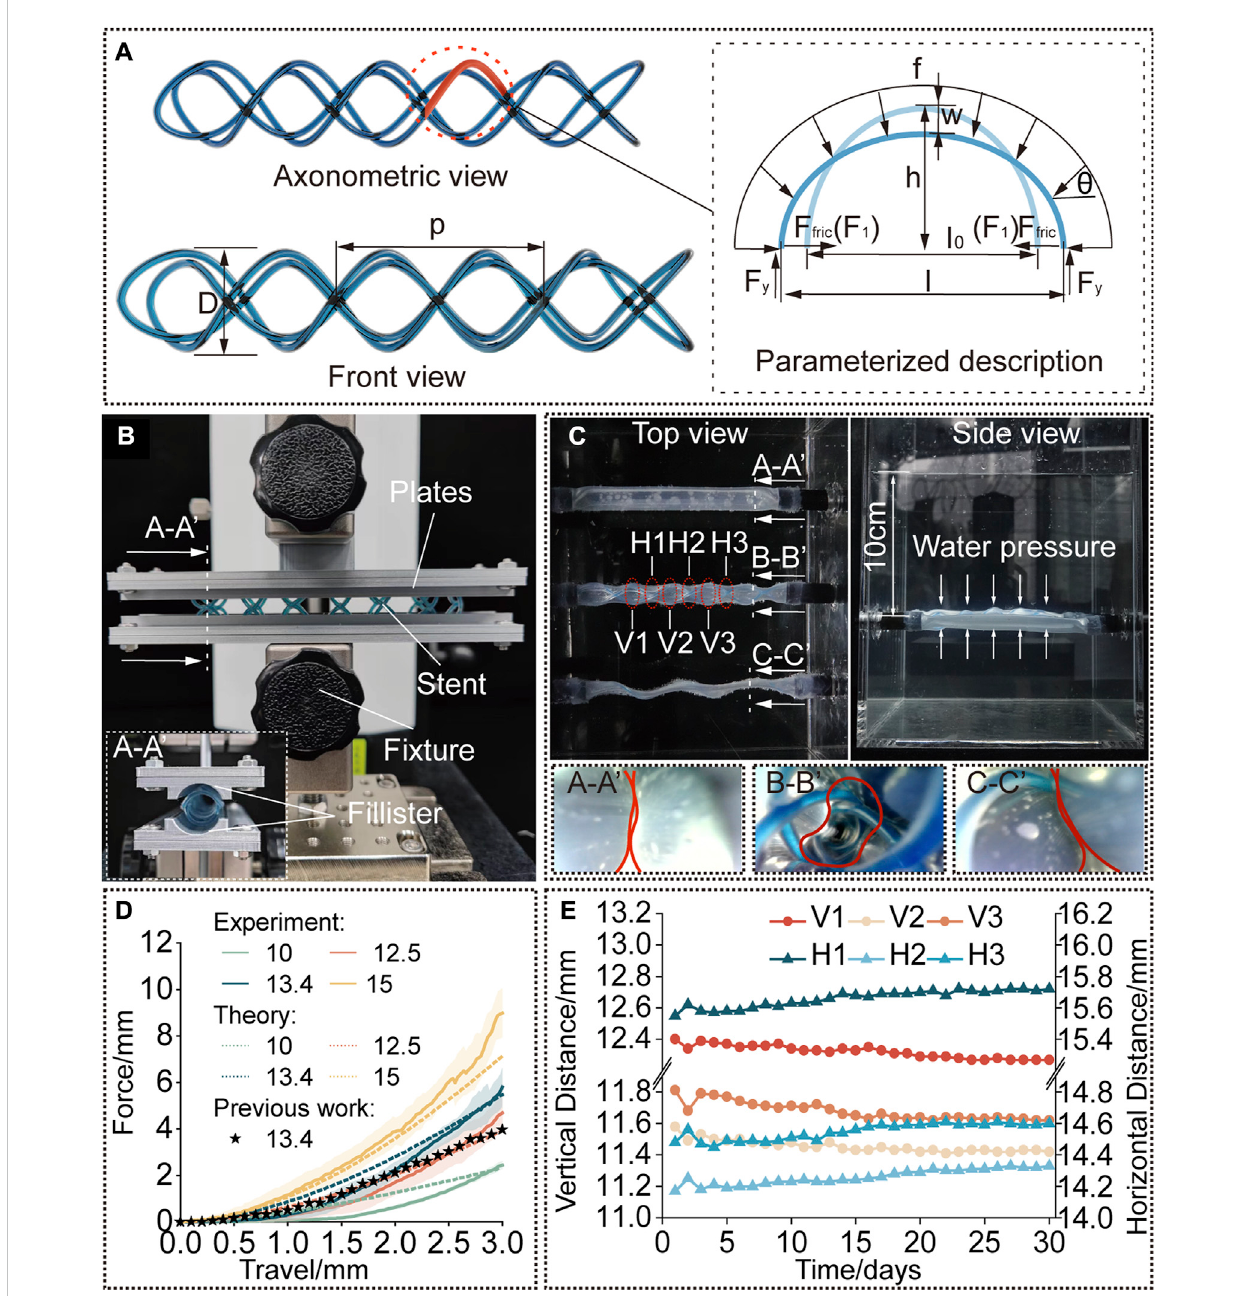
FIGURE 3 Modelling and characterization. (A) A rendered graph of a straight stent and a diagram of its deformation analysis. (B) Compression test setup. The cured stent was positioned between the two plates with fi llisters and compressed by a force-measuring platform. (C) Water tank test setup. The stent is kept inside the phantom tracheal model at 37 ° C and a water pressure at a depth of 10 cm was applied. (D) Compression force versus travel distance. Experimental results compared to the predicted results to verify the model and compared to the results for the single helical stent with the same parameters. (E) Diameters of the stent [interpreted by the vertical and horizontal distances as shown in (C) ] versus time (30